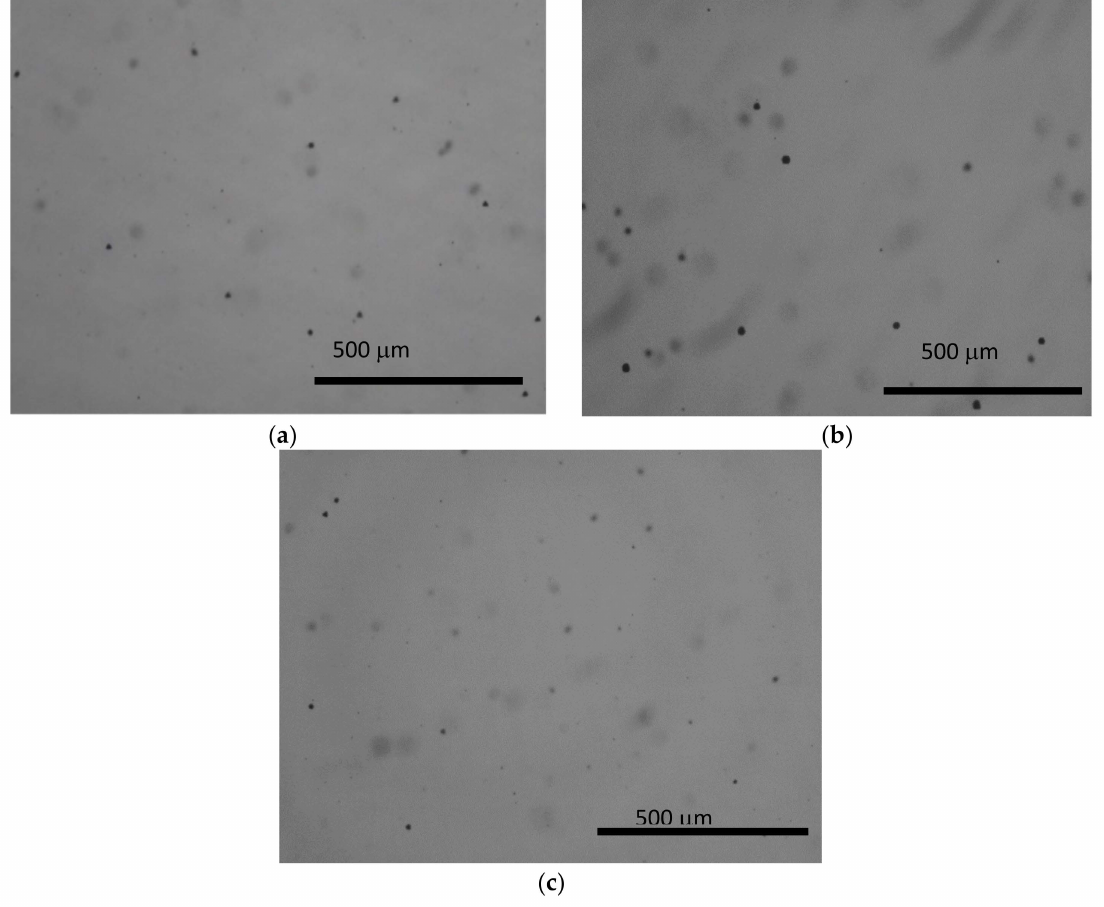
Figure 3. Typical IR Microscopy of CZT:In,Pb. ( a ) tip wafer, ( b ) middle wafer, ( c ) tail